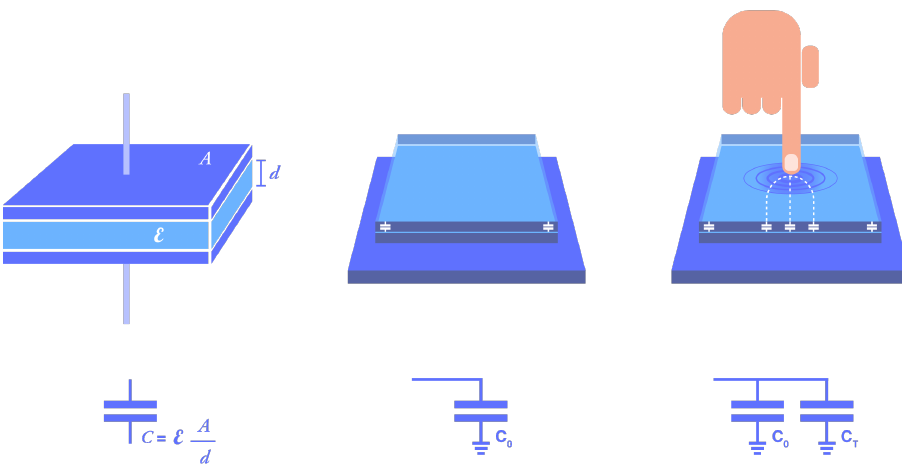
Figure 6. The model representing a capacitive sensor activated by a human finger